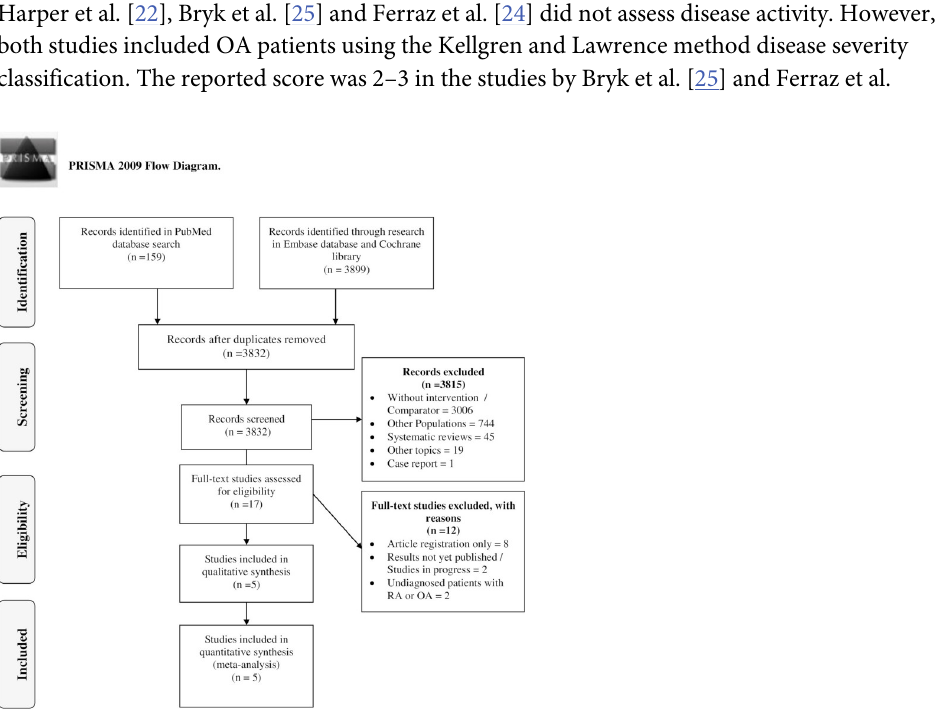
Fig 1. PRISMA. Flow diagram of search results and study